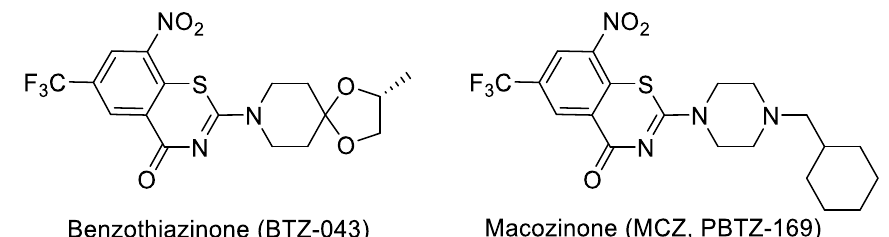
Figure 4. Structures of BTZ and PBTZ.